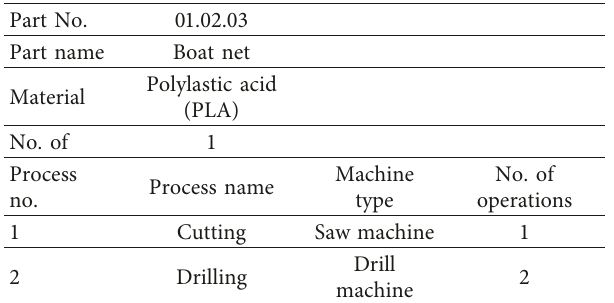
Table 10: Rudder joint.